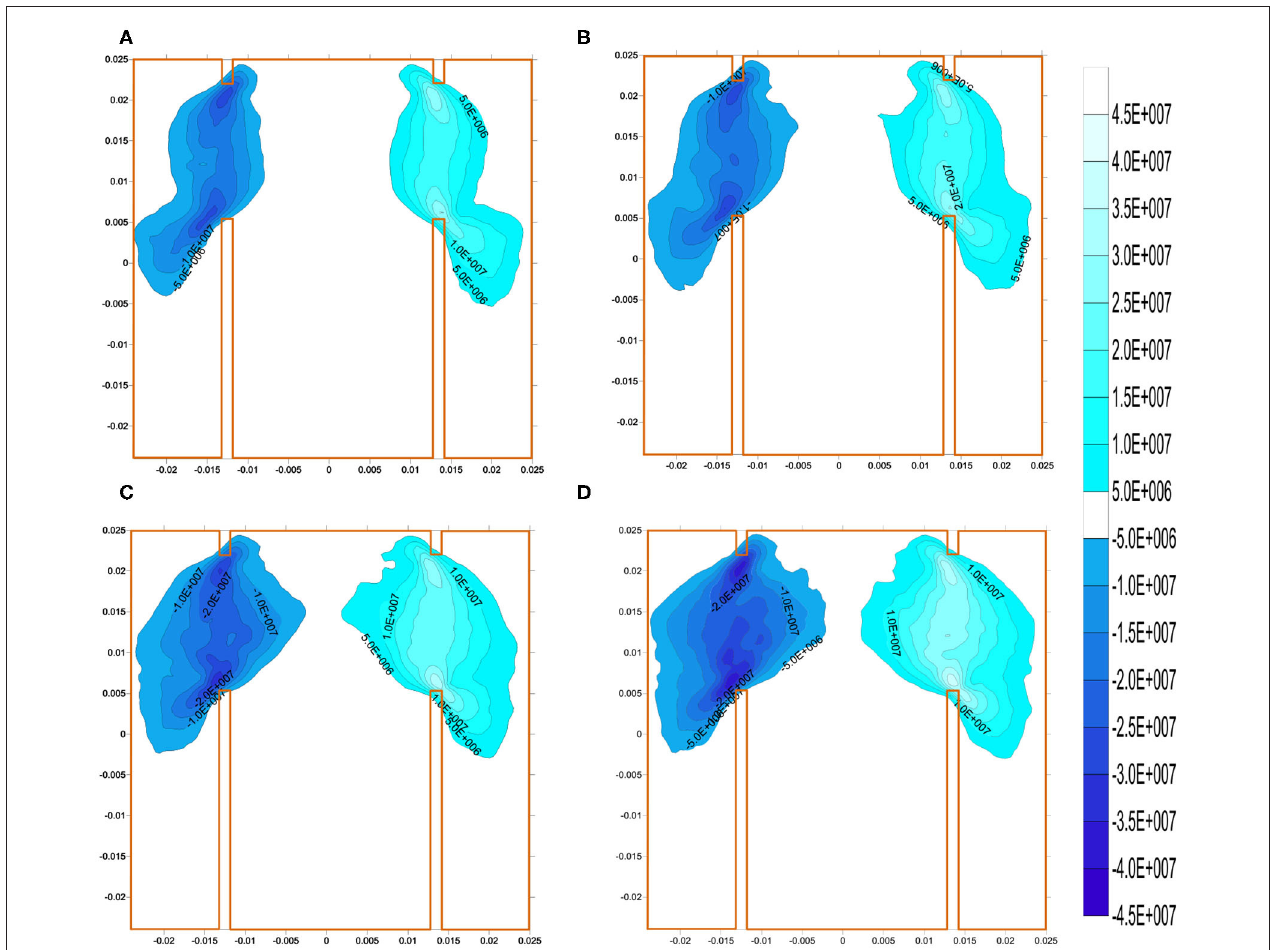
FIGURE 11 | Shear stresses before shear crack propagation: (A–D) are for the confining stresses of 0, 5, 10, and 15 MPa, respectively.